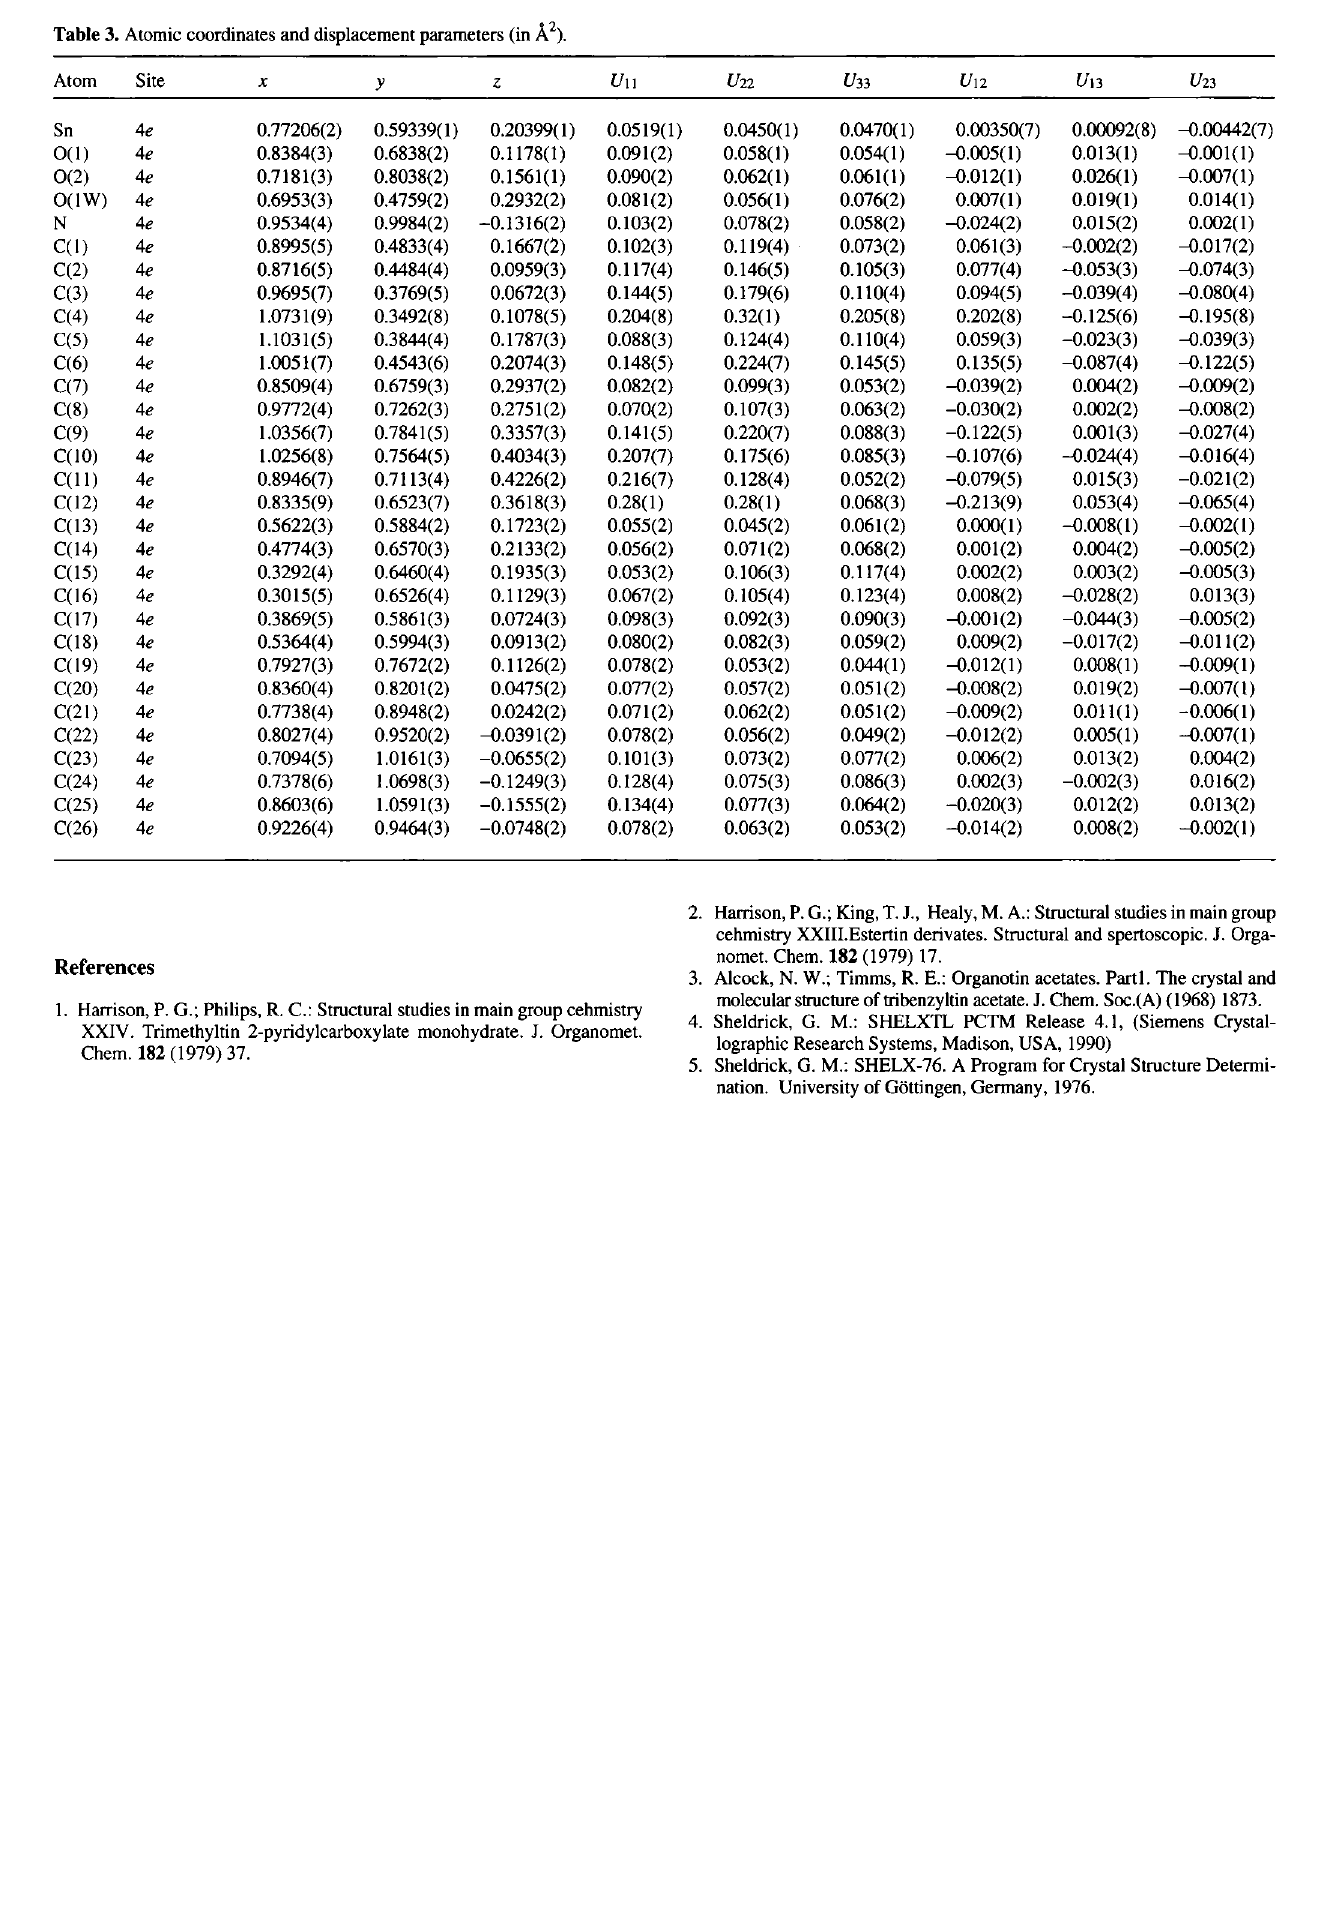
Table 3. Atomic coordinates and displacement parameters (in Ä 2